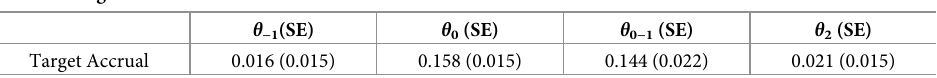
Table 3. Target accrual.